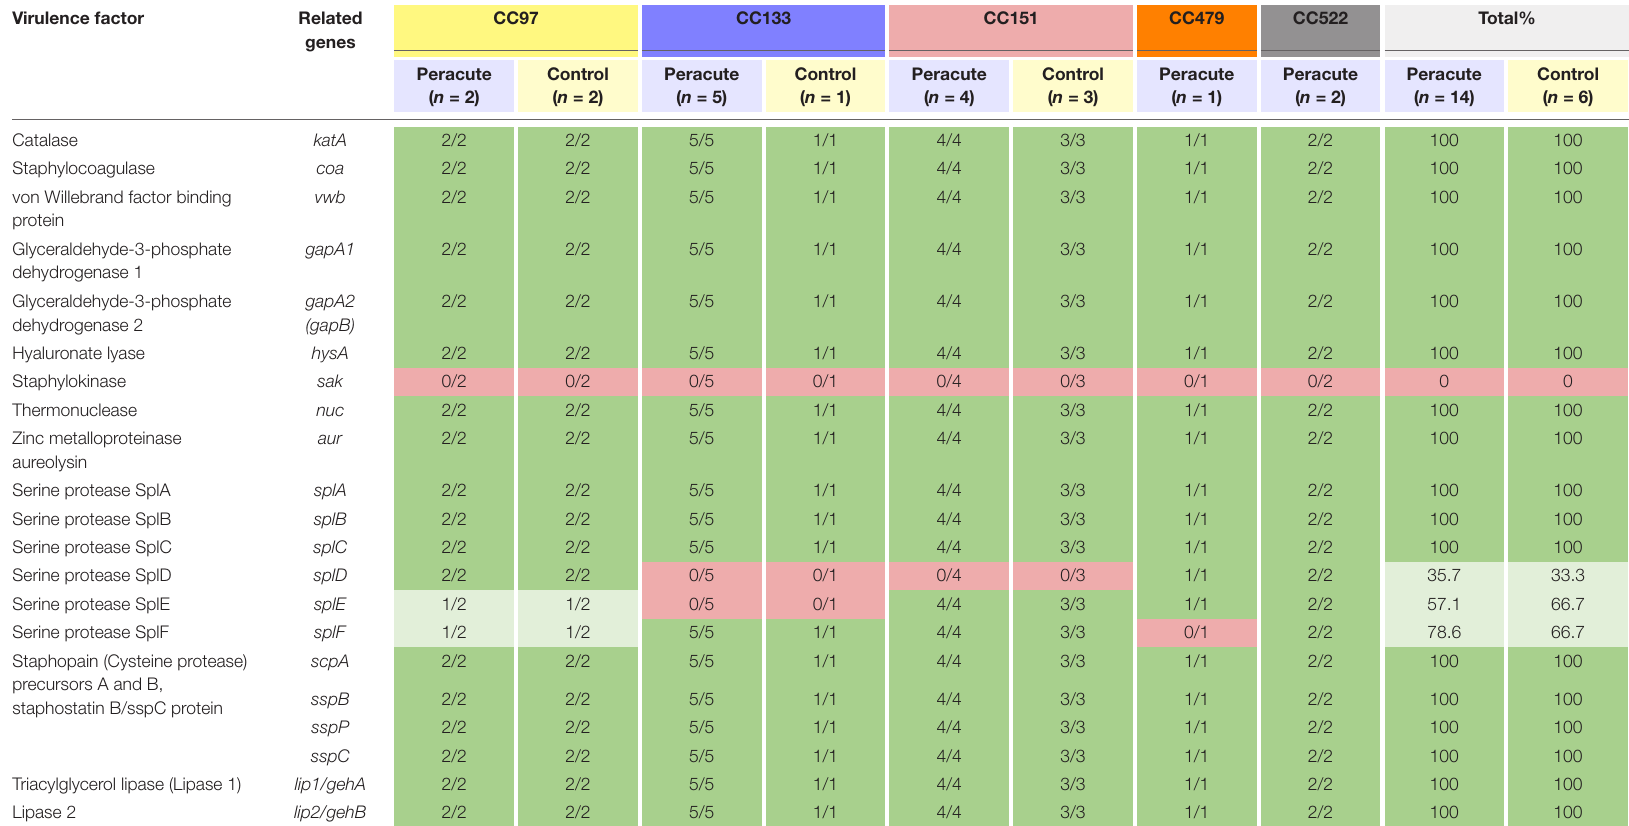
Darker green color indicates genes present in all isolates within a given group; lighter green indicates genes present in part of the isolates within a given group; red indicates genes not detected in any isolates within a given